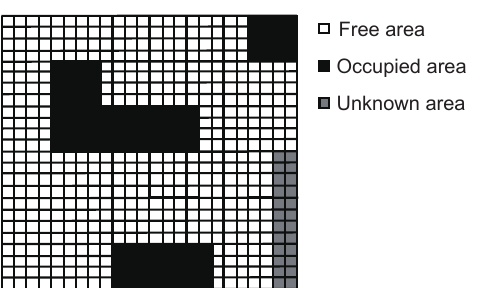
Fig. 1 Illustration of the occupancy grid map for the